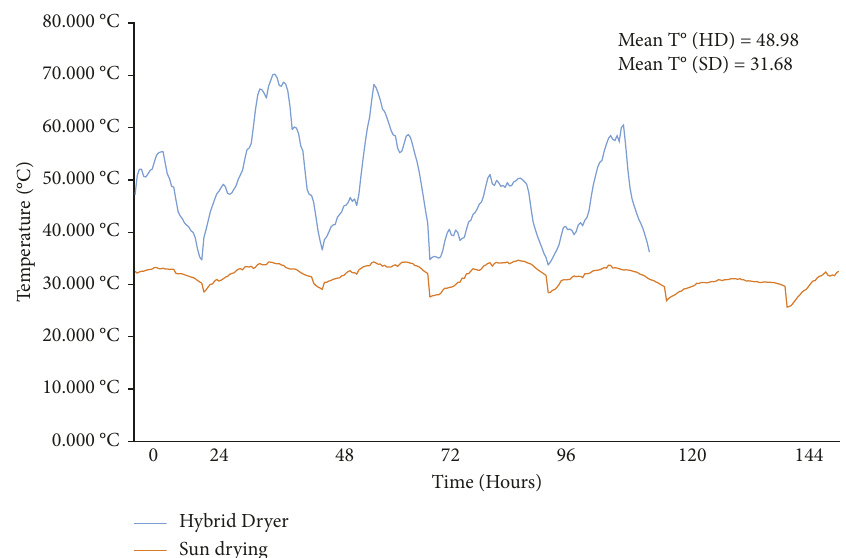
Figure 2: Temperature profile of the two drying methods during the drying